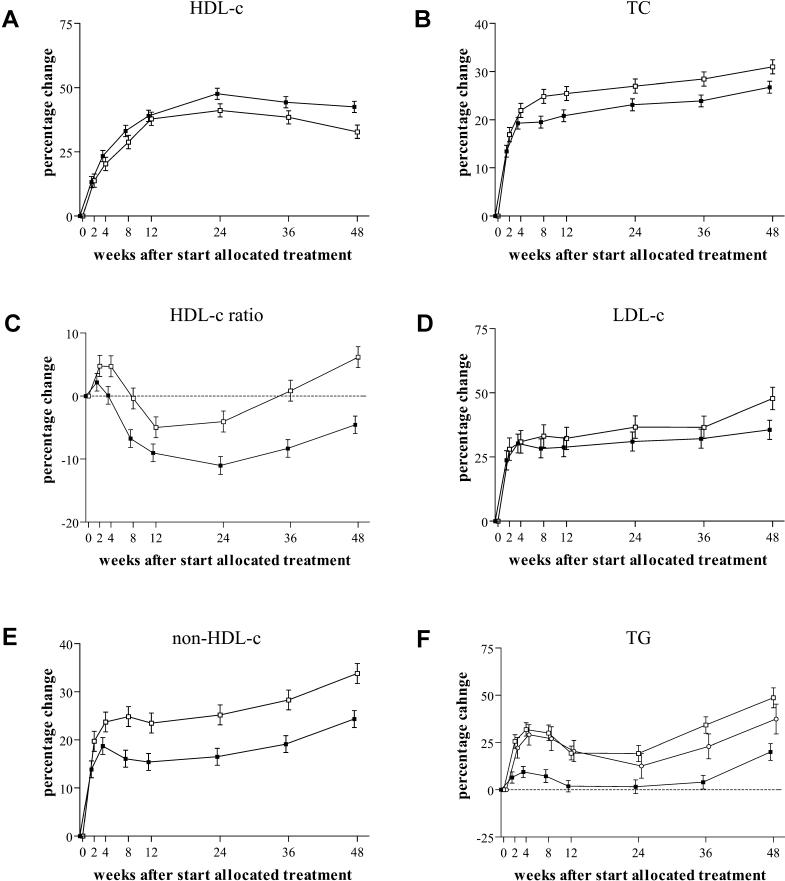
Change in Plasma Concentrations of Lipids and LipoproteinsAdjusted for sex, region, pVL decrease, and CD4+-cell increase.